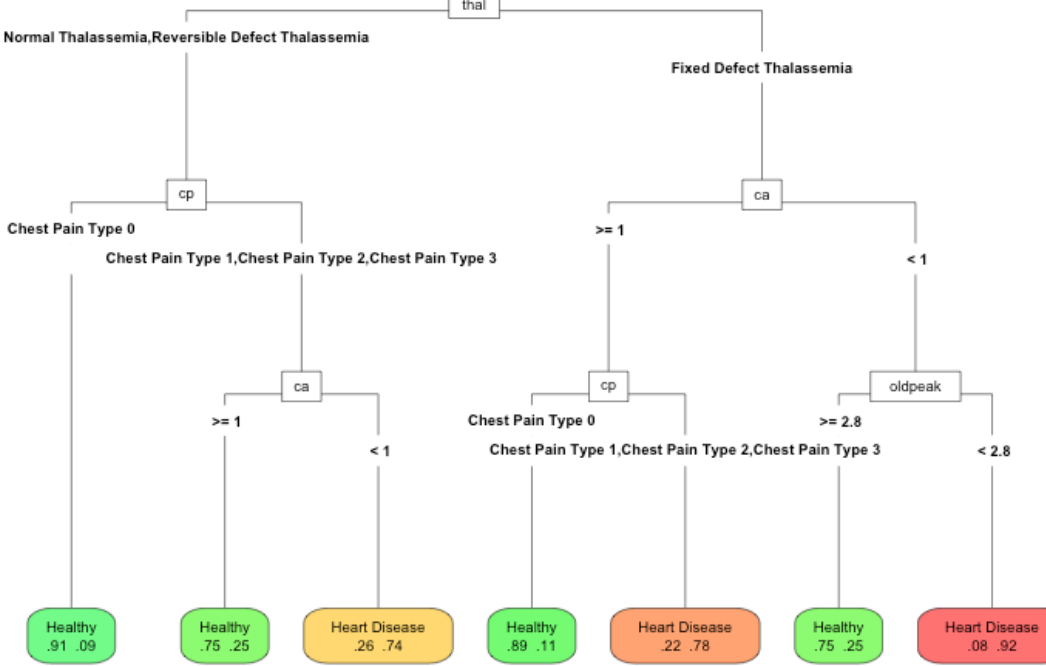
Figure 9. Performance of RPART using 33% of features with a maximum tree depth of